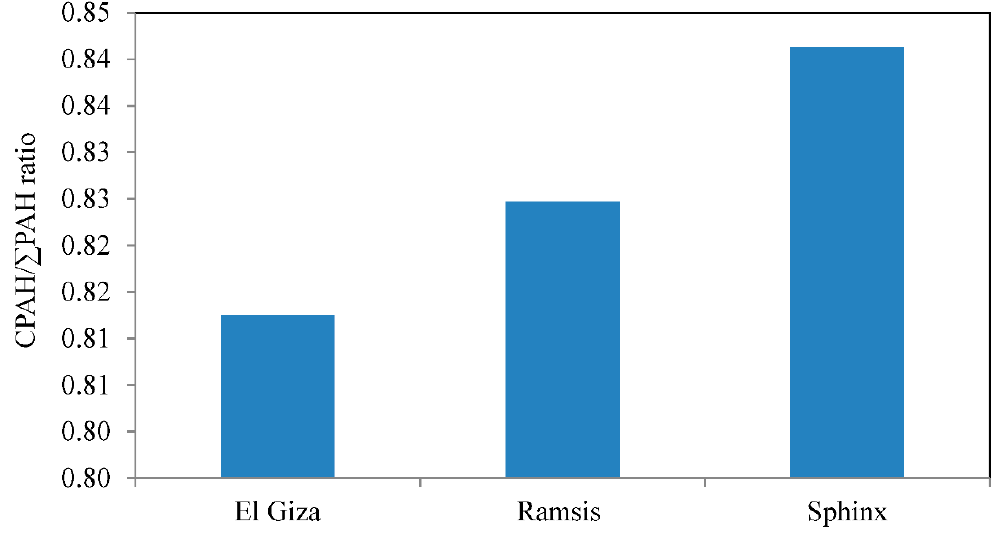
Figure 7. Diagnostic concentration ratios of selected PAH compounds.